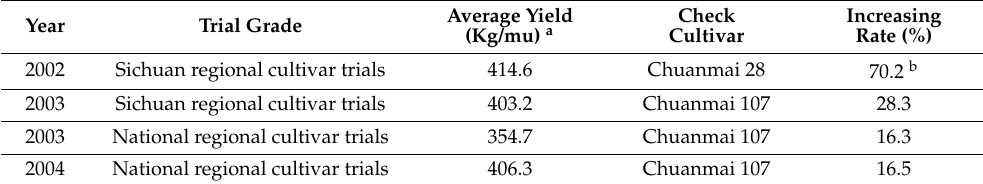
Table 2. Yield performance of Chuanmai 42 in Sichuan and national regional cultivar trials.